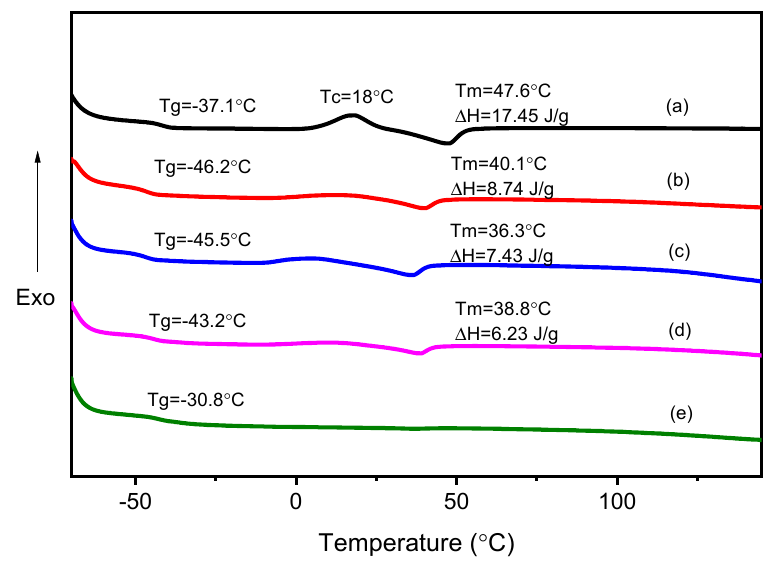
Figure 4. DSC thermograms: ( a ) T1-00, ( b ) T1-20, ( c ) T1-30, ( d ) T1-50, and ( e ) T1-70.